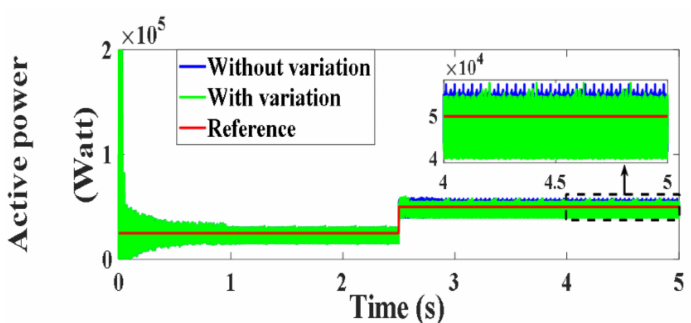
Figure 132. Variation of R s ( Ω ).